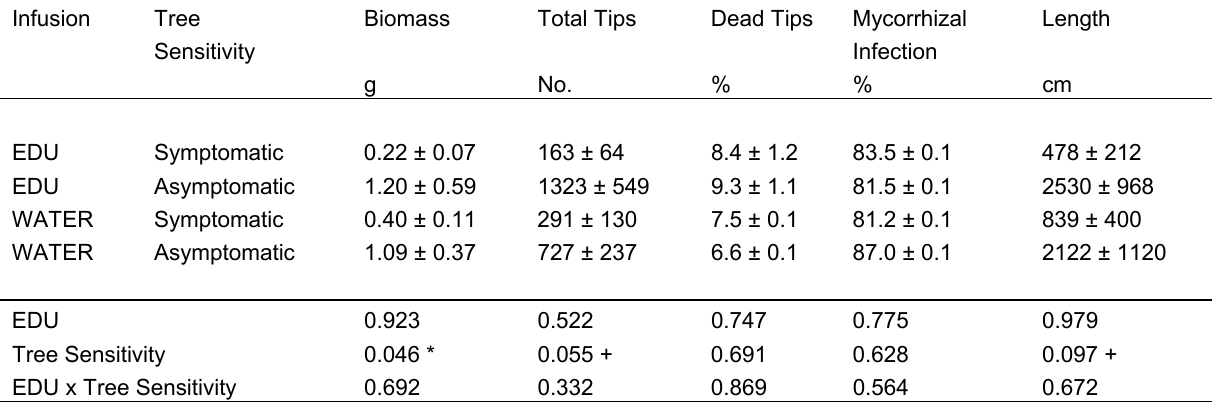
Means (±SE) and Levels of Significance of a Two-Way ANOVA for the Effects of EDU (Water vs. EDU-Infused Trees) and Tree O 3 Sensitivity (Symptomatic vs. Asymptomatic) on: Biomass, Total Number of Tips, Percent of Dead Tips and Mycorrhizal Infection, and Length of Fine Roots (diameter<2 mm) in a Standard Volume (500 ml) of Soil collected under Adult Fraxinus